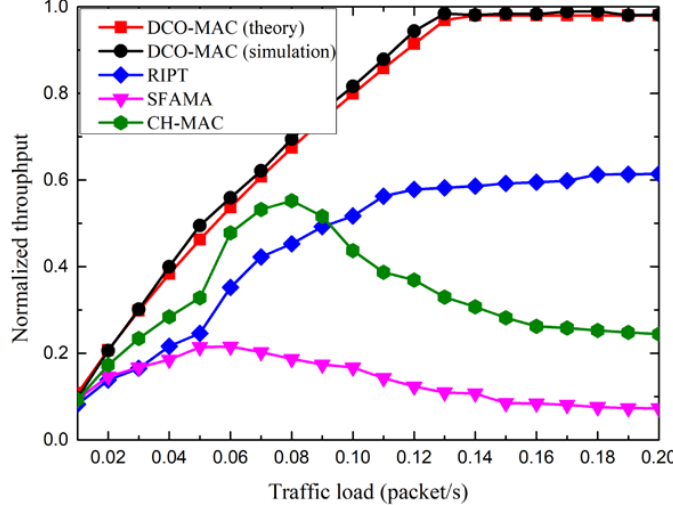
Figure 14. The normalized throughput of the DCO-MAC protocol.